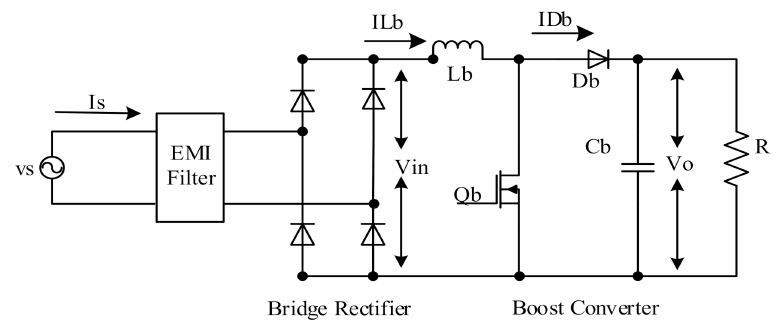
Figure 3. Schematic diagram of the conventional AC-DC PFC boost converter.